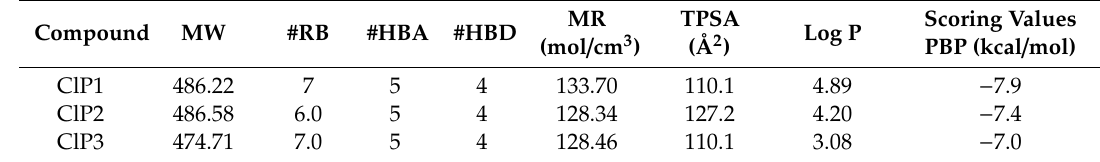
Table 6. Drug-likeness properties calculated for the three new proposed compounds.